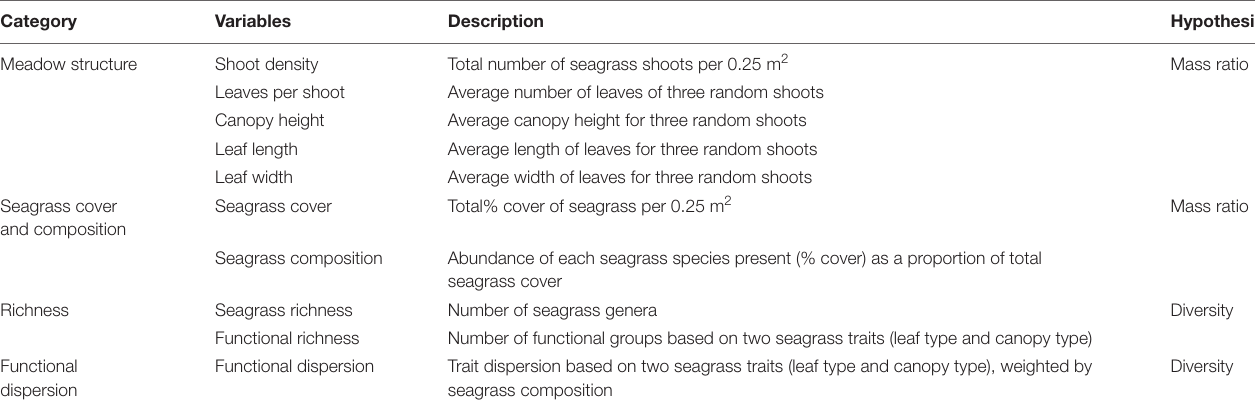
TABLE 1 | Seagrass meadow structure, cover, composition, richness and community-weighted trait values investigated as predictors of fish abundance and species richness in the present